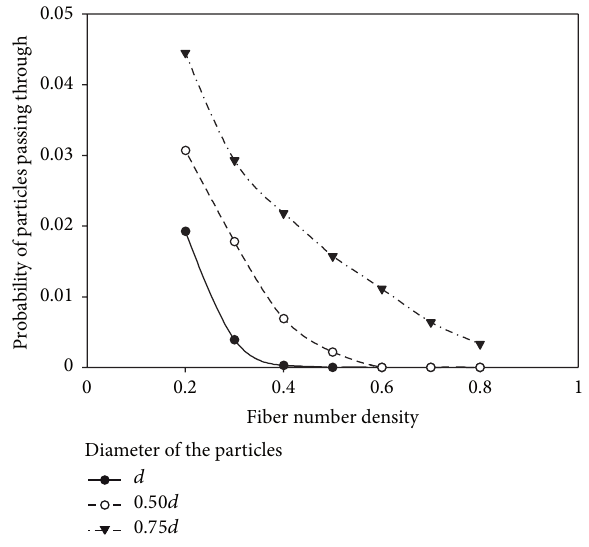
Figure 8: The probability for a particle with different size to successfully move through the 2D pore in the structures made of various fiber densities.